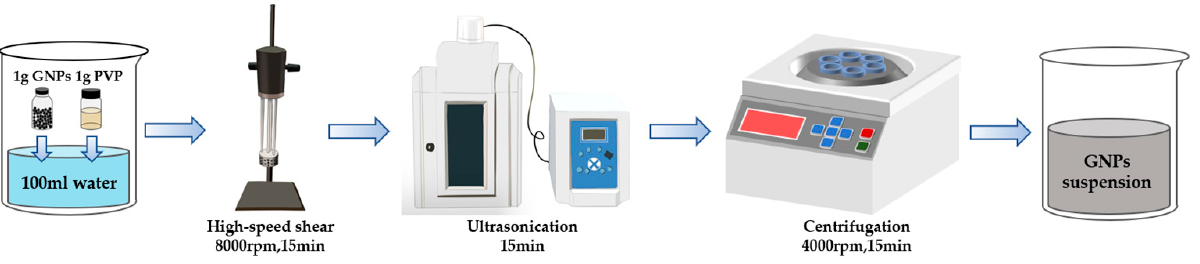
Figure 9. The optimal dispersion method of GNPs suspensions.